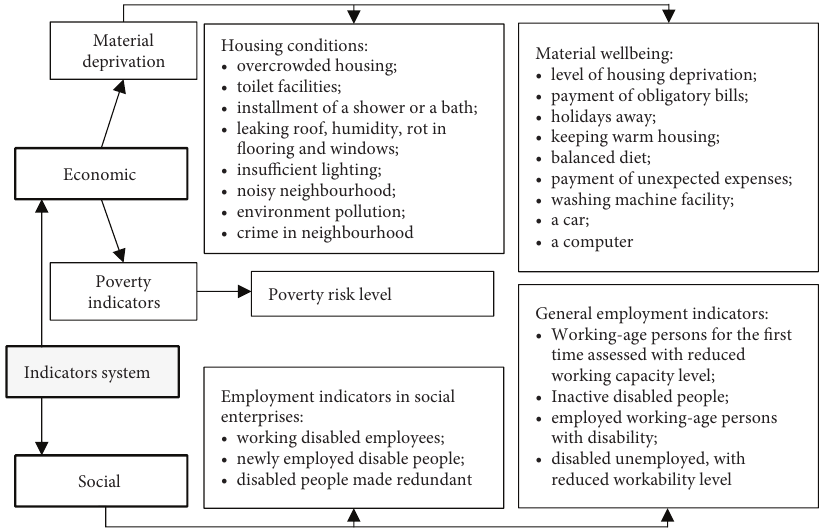
Figure 1. System of indicators applied in the evaluation (source: created by